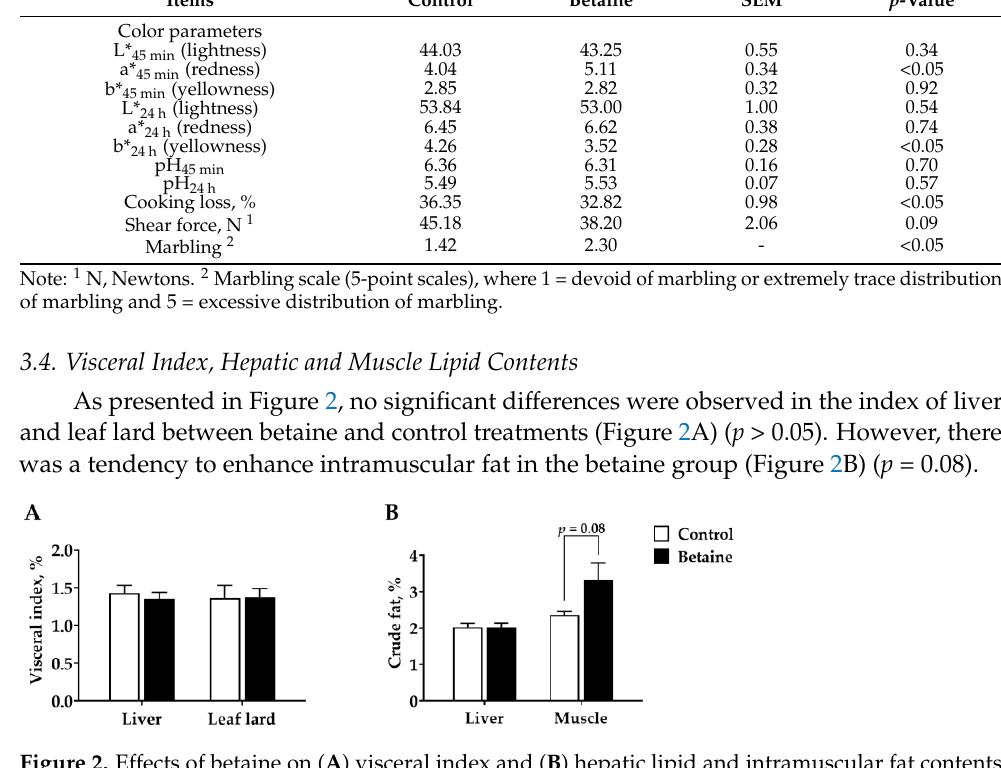
Table 3. Effects of betaine on meat quality in growing-finishing pigs.